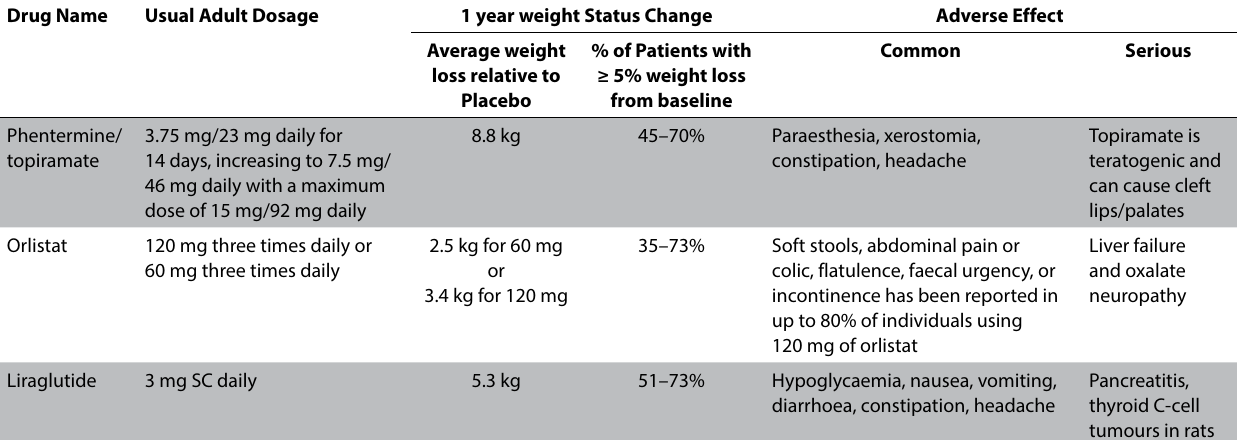
Table 4: Overview of pharmacotherapy used in the management of obesity 7,15-19 Drug